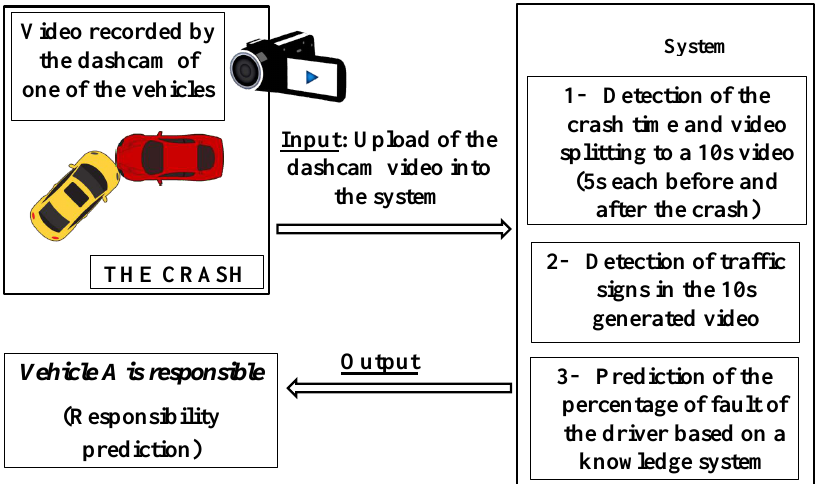
Figure 1. The architecture of the system with the collaboration between the three